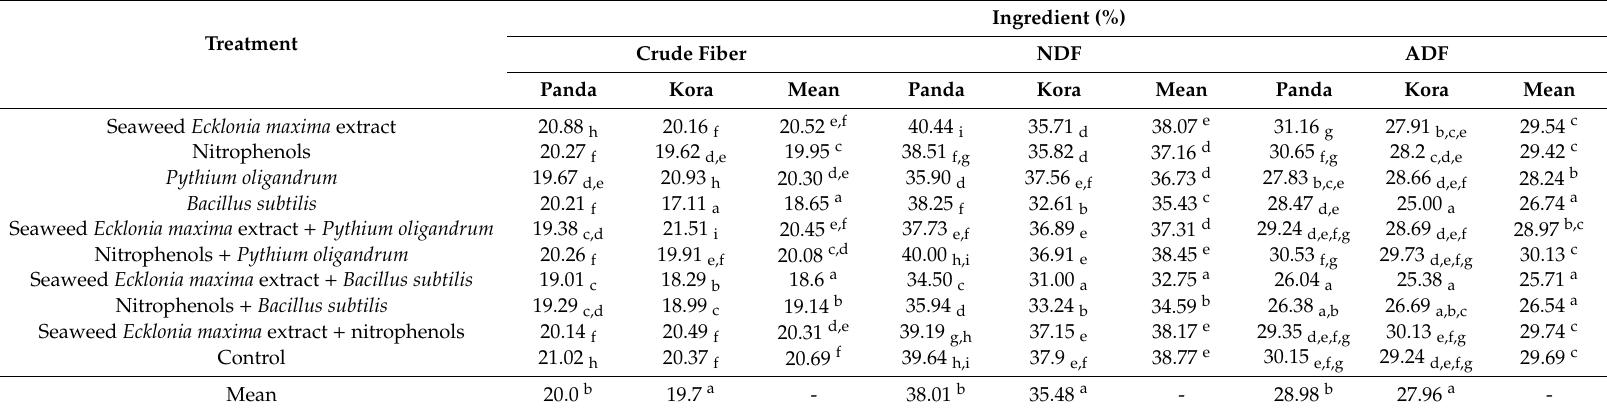
Table 2. E ff ect of cultivar and treatment on the crude fiber, neutral detergent fiber (NDF), and acid detergent fiber (ADF) of buckwheat sprouts.